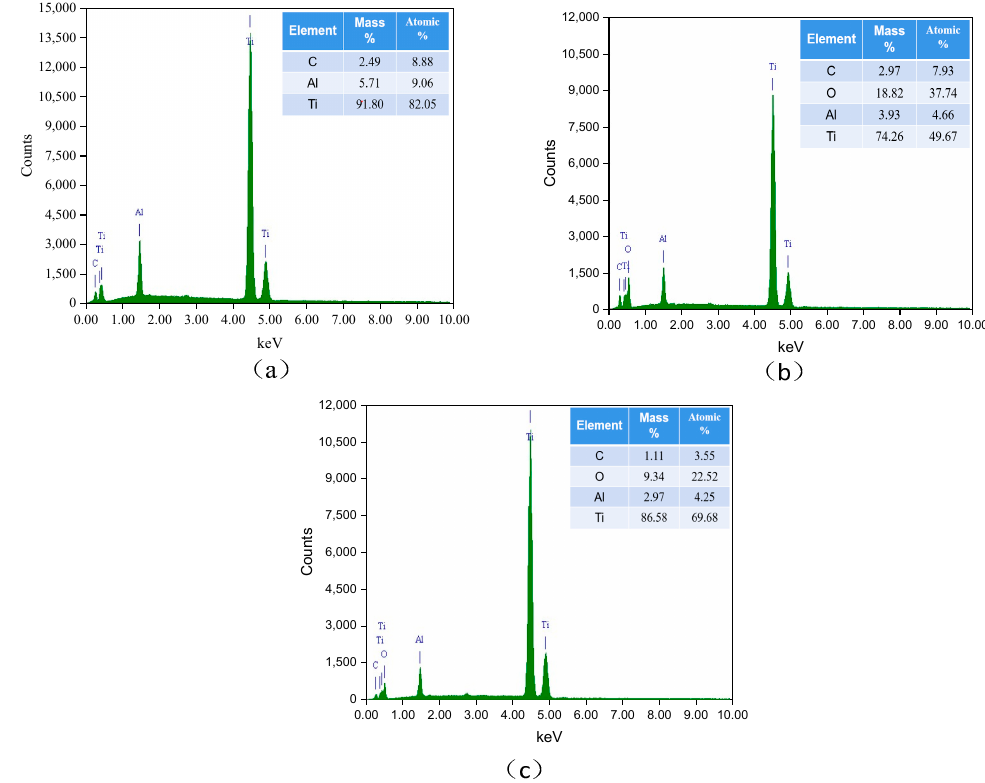
Figure 4. Comparison of EDS spectrum of samples used in the experiment: ( a ) is the area 002 in Figure 3b; ( b ) is the area 001 in Figure 3d; ( c ) is 001 area in Figure 3f.